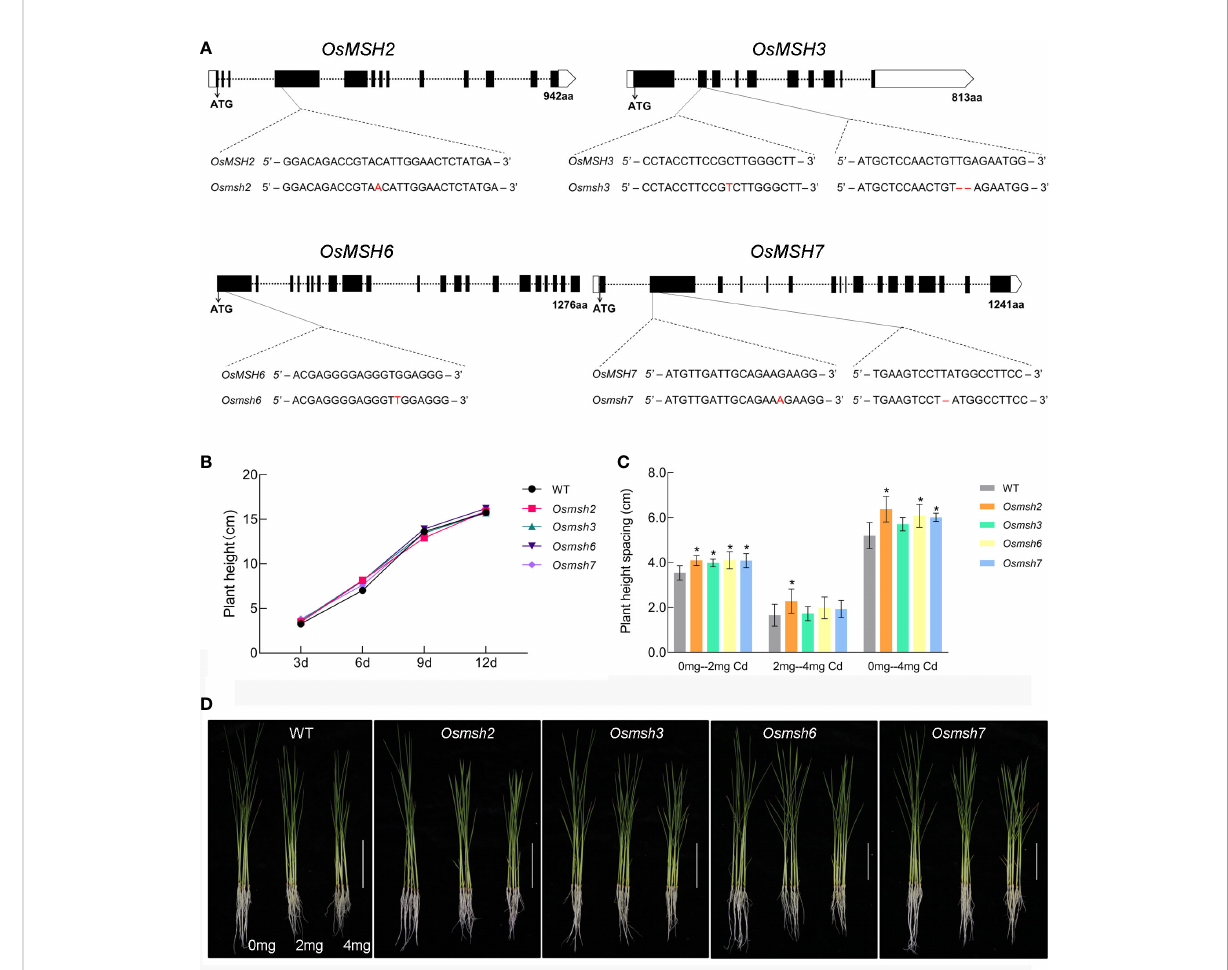
FIGURE 3 Phenotype of rice mutant seedlings under cadmium stress. (A) Gene structure of the rice MSH gene and editing loci for mutants. (B) Growth curves of rice msh mutant and wild-type seedlings from the start of germination to the 12-day stage. (C) Statistics of plant height differences between rice msh mutant and wild-type seedlings under 2 mg and 4 mg stress. (Student ’ s t-test, p < 0.05). (D) Phenotypic photographs of rice msh mutant and wild-type seedlings under 2 mg and 4 mg stress(n = 5 Scale bars: 10 cm). * indicates